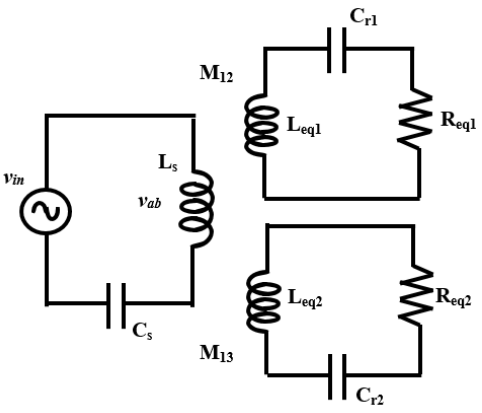
Figure 2. Equivalent circuit of two loads fed IH system.